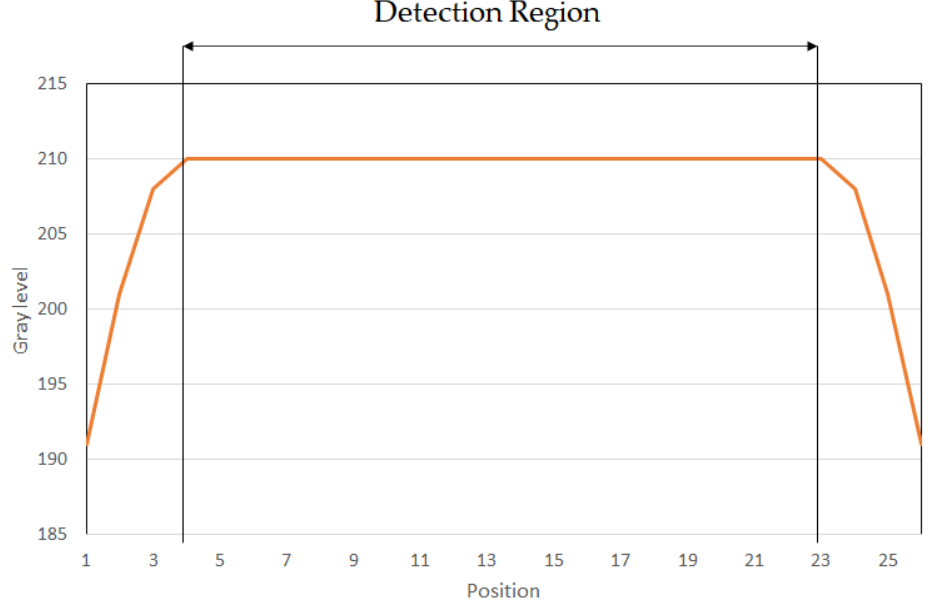
Figure 8. The uniformity of the side-view illumination indicating the distribution.